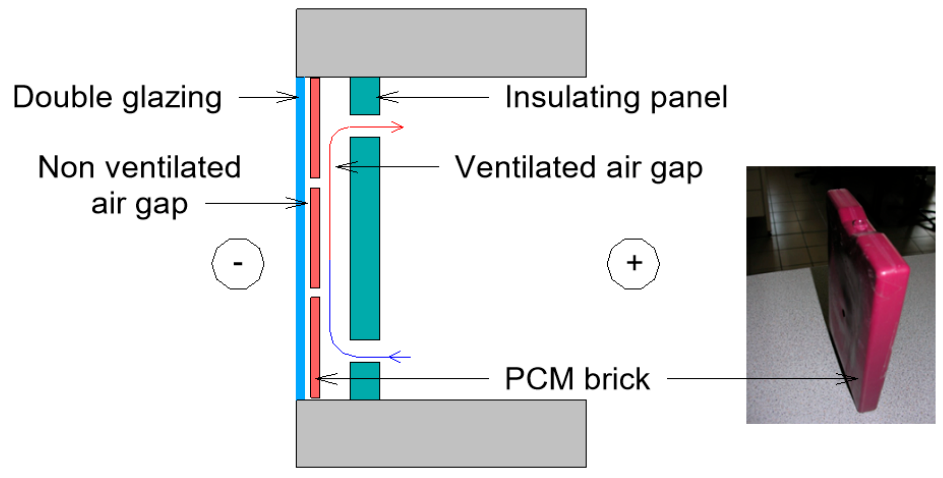
Figure 6. The Trombe composite wall with PCM (data from ref. [70]).